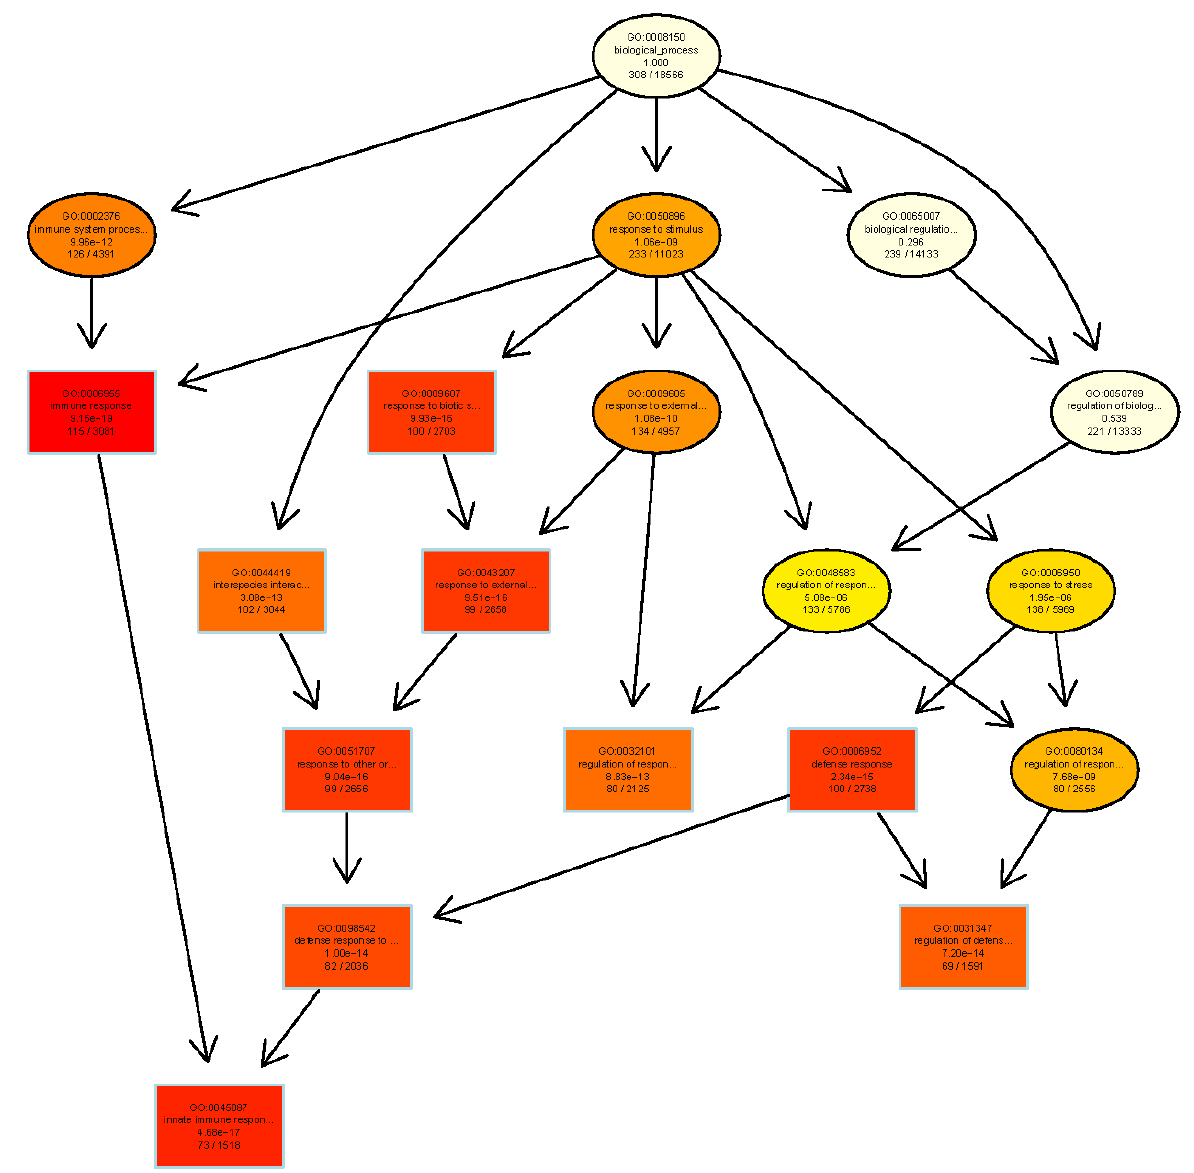
Figure 4. An abridged directed acyclic graph representation of gene ontology (GO) assignments of differentially expressed genes based on biological processes. The top ten most significant GO terms were set as square, and the remaining GO terms were set as circular. The darker the color, the more significant the GO term, the color from light to dark: colorless – light yellow – dark yellow – red. (For interpretation of the references to color in this figure legend, the reader is referred to the web version of this article).